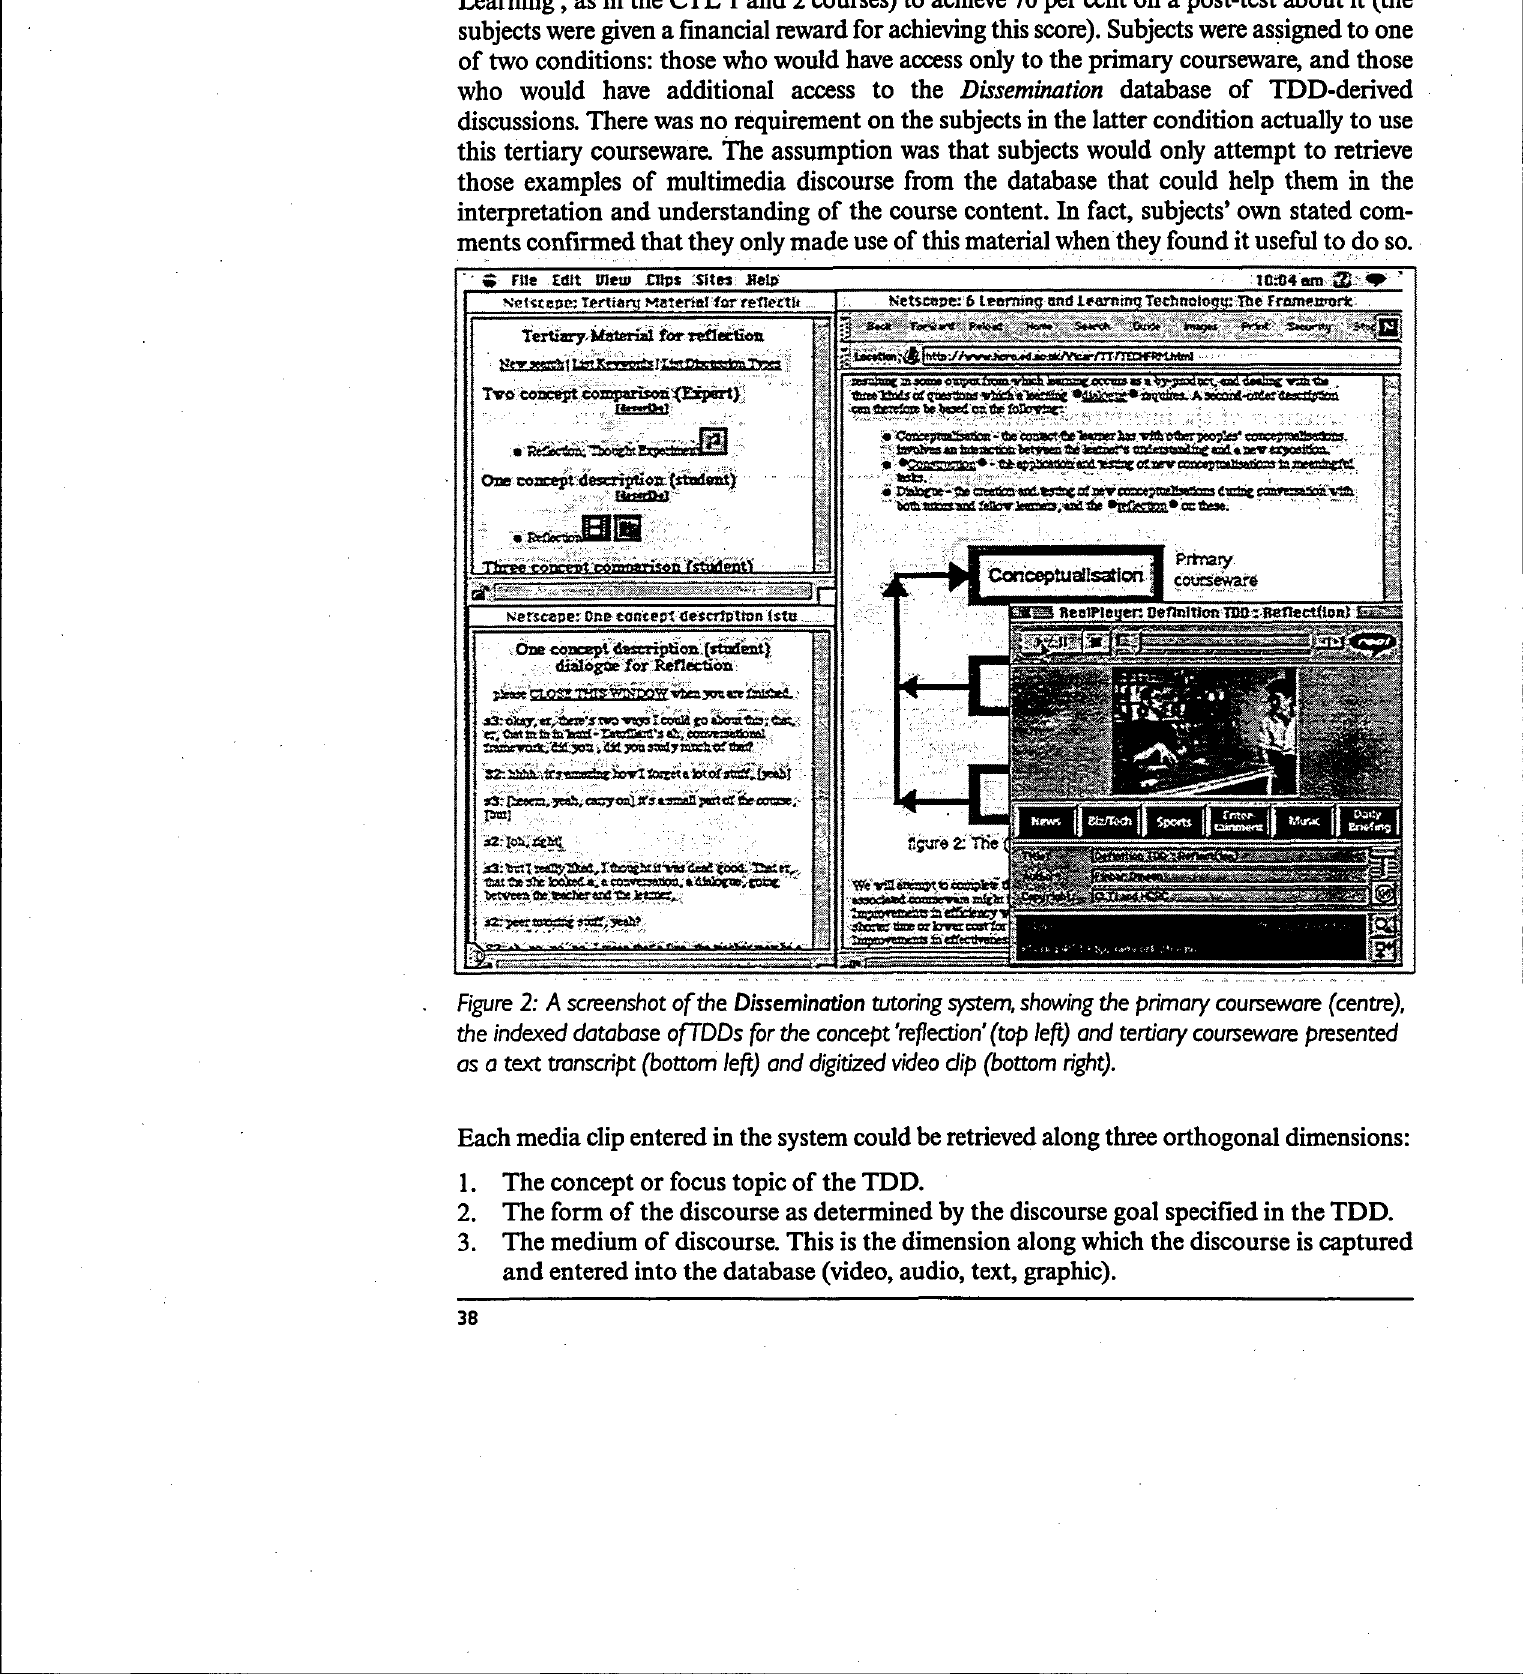
Figure 2: A screenshot of the Dissemination tutoring system, shewing the primary courseware (centre), the indexed database ofTDDs for the concept 'reflection'(top left) and tertiary courseware presented as a text transcript (bottom left) and digitized video dip (bottom